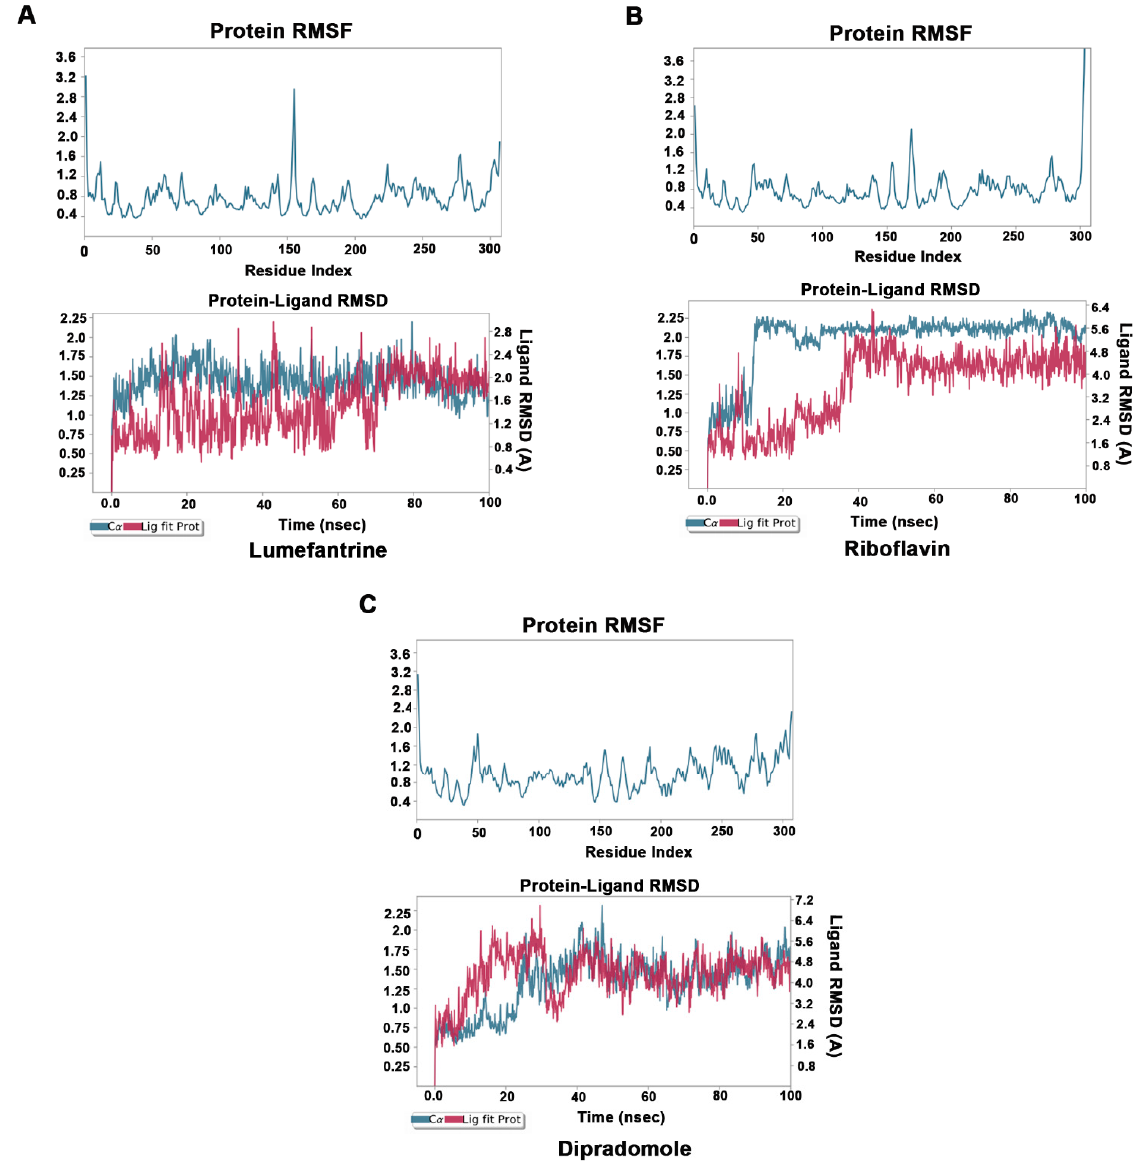
Figure 4. Molecular dynamics studies of M pro –drug complexes: Molecular dynamics simulations for M pro –lumefantrine ( A ), M pro –riboflavin ( B ), and M pro –dipradomole ( C ) complex. Low root mean square fluctuations of C α protein atoms in upper panel suggest protein was stable during the simulation run. The stable RMSD of C α protein atoms (Blue) and Ligand RMSD (Red) in lower panel suggests formation of stable protein–ligand complex.